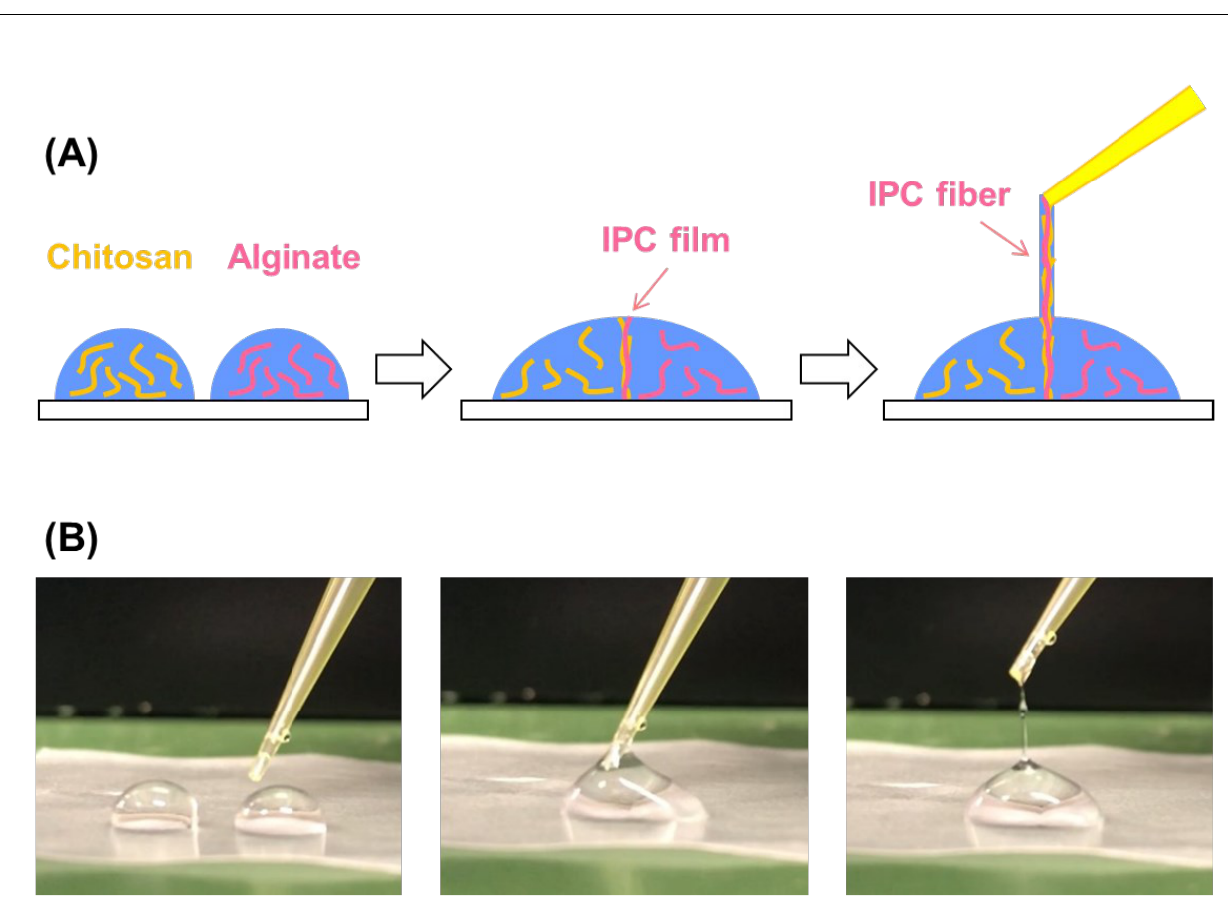
Figure 1. An IPC fiber of chitosan – alginate: ( A ) fabrication scheme; ( B ) photographs of fabrication. Droplets of chitosan and sodium alginate solutions were placed in contact, and an IPC fiber was drawn out using the pipette tip.